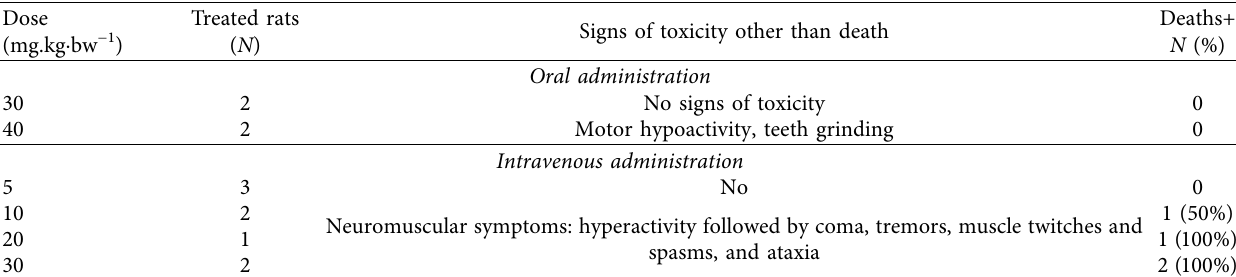
Neuromuscular symptoms: hyperactivity followed by coma, tremors, muscle twitches and spasms, and ataxia